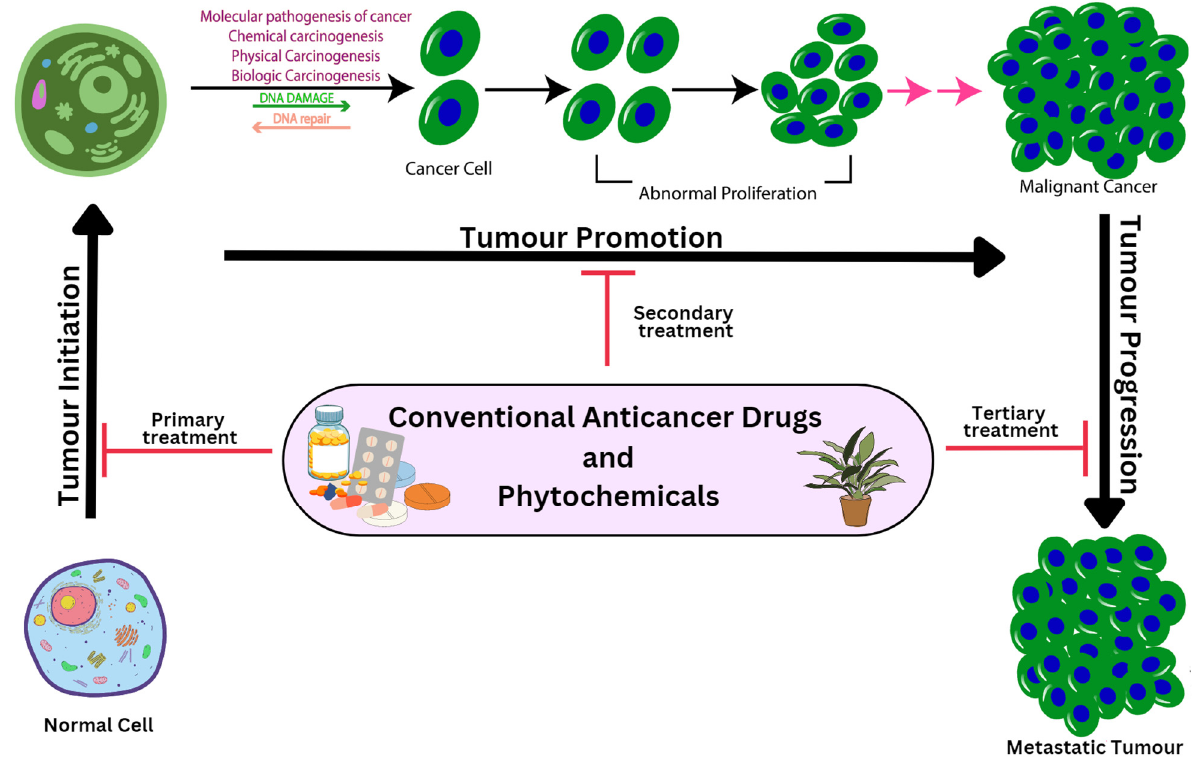
Figure 1. Various stages for progression of cancer along with their treatment